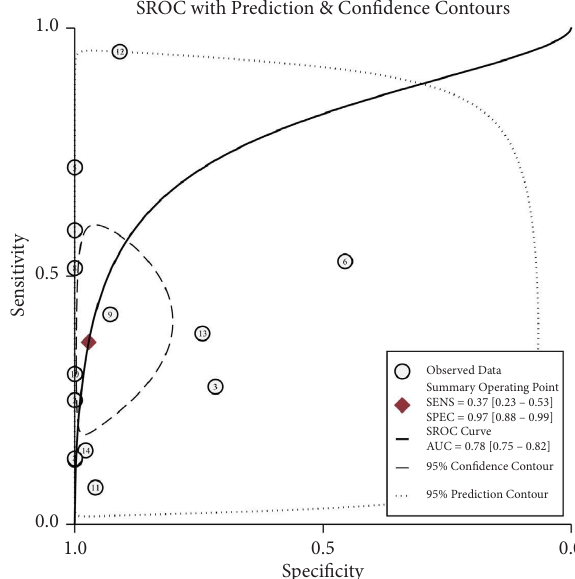
Figure 3: SROC curves of GSTP1 methylation in cfDNA for the diagnosis of PCa.